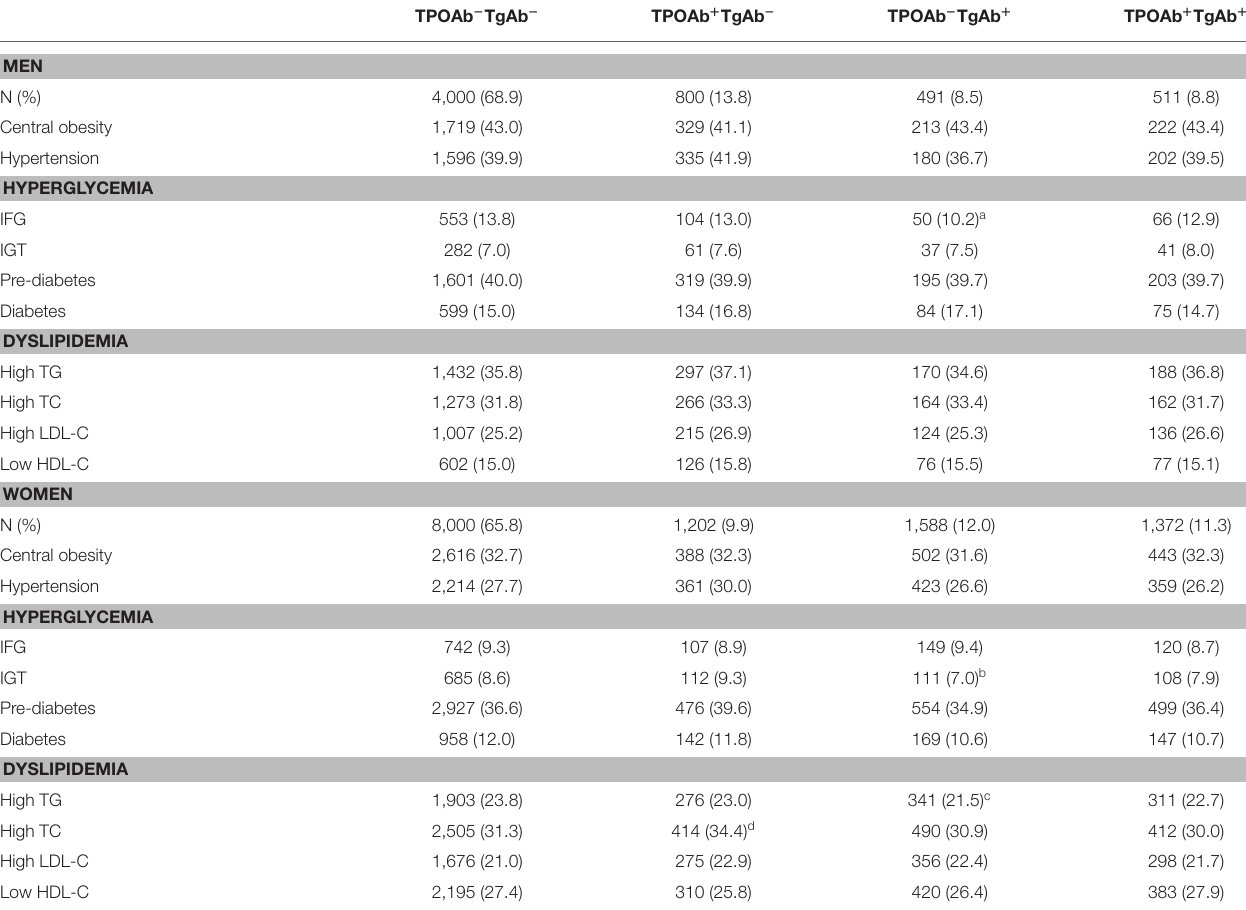
TABLE 3 | Percentage of subjects with hyperglycemia and dyslipidemia among those with differential expressions of serum TPOAb and